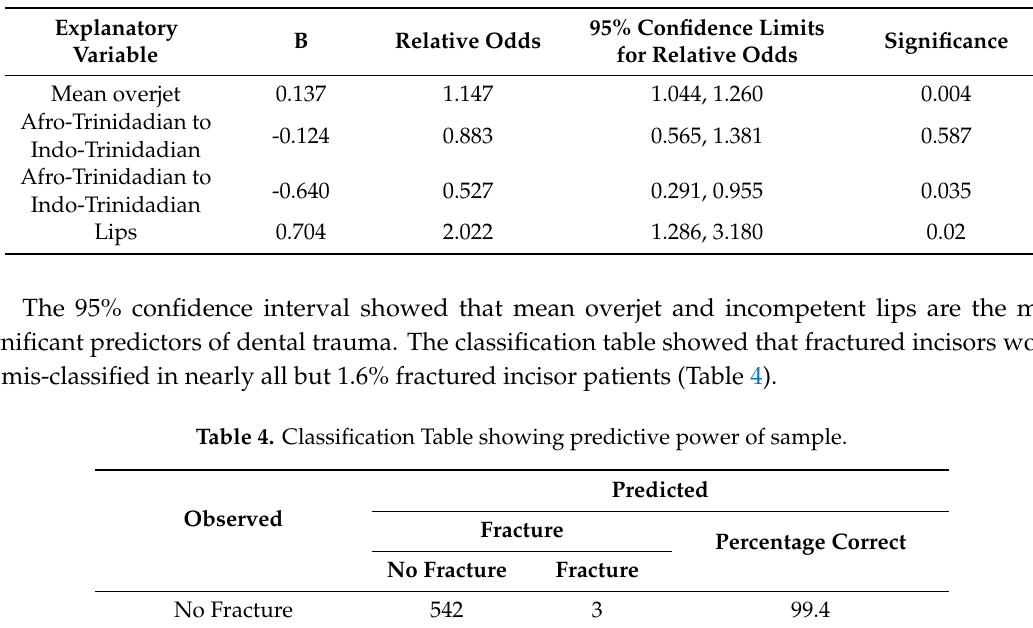
Binary Logistic Regression model containing the variables, mean overjet, ethnicity, lip competence.